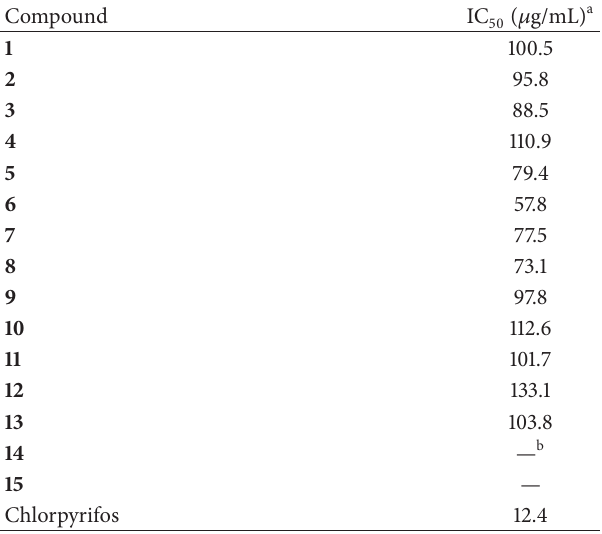
Table 1: AChE inhibitory activity of compounds 1–15